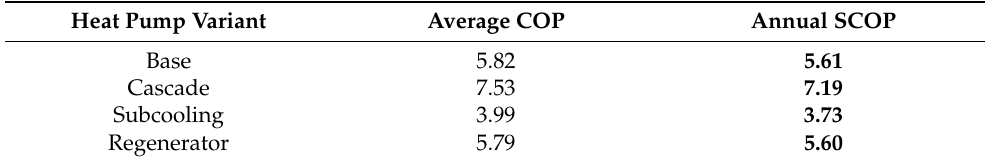
Table 4. Results of COP and SCOP calculations based on historical data from